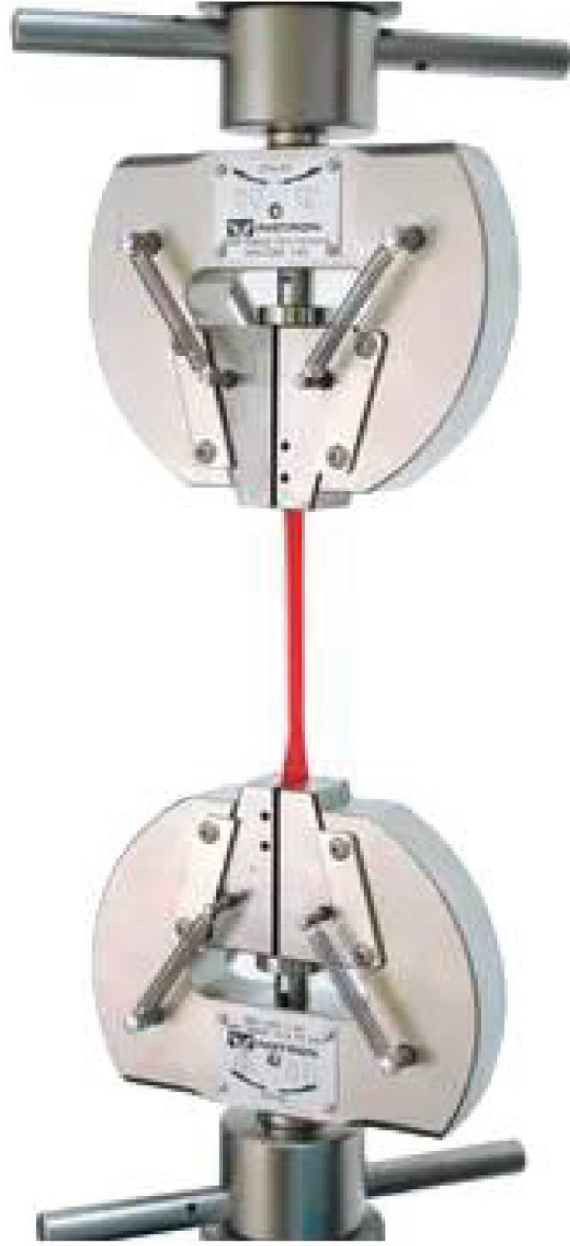
Figure 3: Bonding force tensile test.